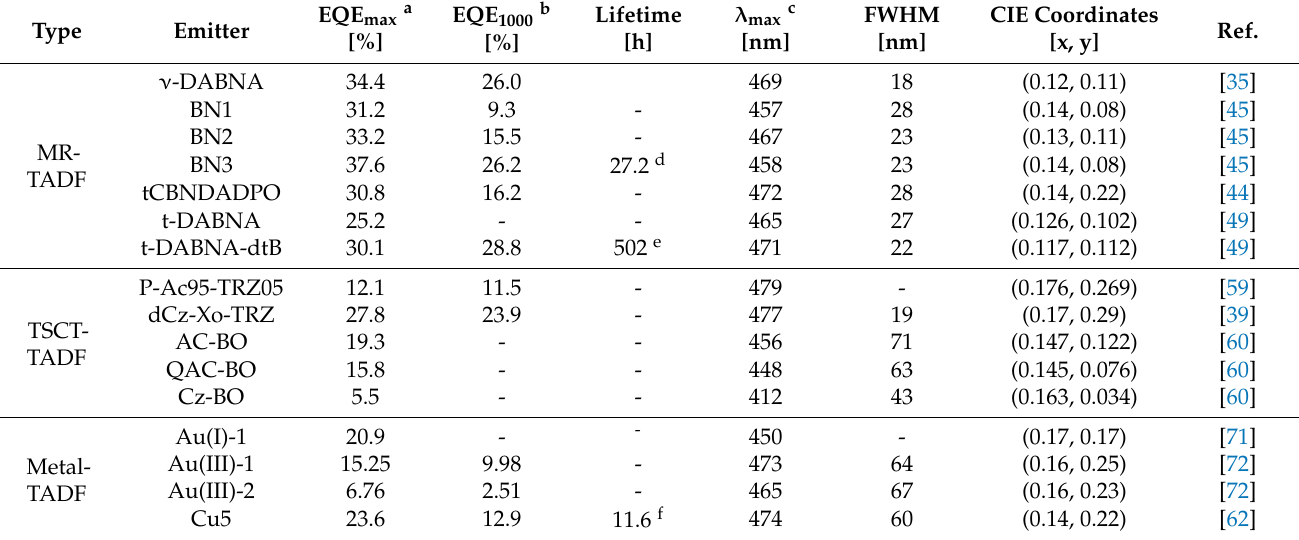
Table A2. Key performances of blue OLEDs described in this review and recent results.